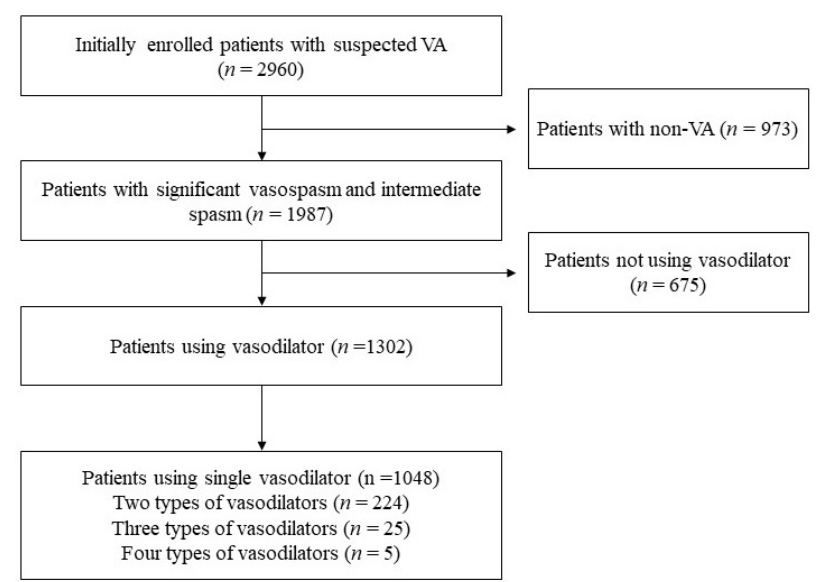
Figure 1. Study population selection process.